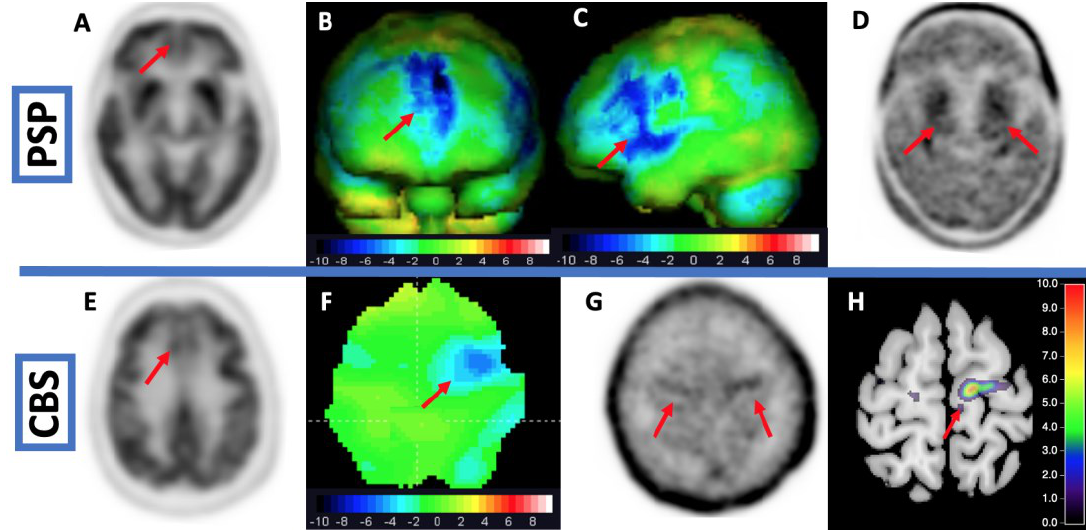
Figure 4. Top row: 60-year-old woman with falling, vertical gaze palsy and agrammatic language. ( A ) Native FDG-PET. ( B ) + ( C ) Z-deviation map in comparison to a healthy inhouse control group. The FDG-PET shows hypometabolism in the frontomesial and left frontolateral cortical regions, suitable but not sufficient for the diagnosis of PSP. The subsequent tau PET with 18F-PI-2620 ( D ) shows tau depositions in the basal ganglia. Diagnosis of a probable PSP could be confirmed. Bottom row: 70-year-old patient with dystonia and hyperreflexia of the right arm, and apraxia. DAT-SPECT was normal. FDG-PET revealed hypometabolism in the frontomesial cortical region and in the left precentral gyrus. ( E ) Native FDG-PET. ( F ) Z-deviation map in comparison to a healthy inhouse control group. The subsequent tau PET with PI-2620 ( G ) shows tau deposition in the bilateral precentral gyrus, accentuated on the left side. ( H ) Z-deviation map of the PI-2620 binding potential in comparison to a healthy inhouse control group. Normal DAT-SPECT and missing tau deposition in the basal ganglia contrasted with cortical tau deposition, favoring the diagnosis of CBS with underlying 3R/4R-tauopathy (AD) versus 4R tauopathy as CBD. Additional amyloid-PET (cortical amyloid deposition) or CSF biomarker (reduced α -Amyloid-1-42) may help to confirm